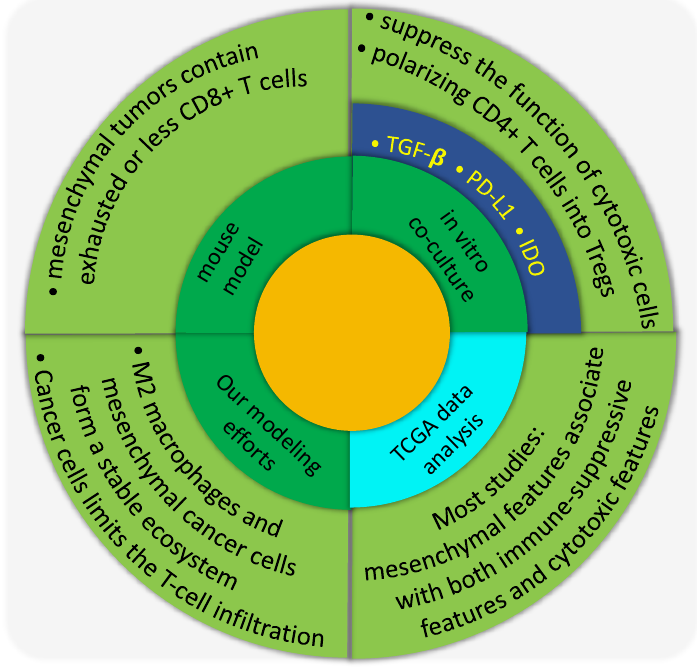
Figure 6. The relationship between EMT and immune response as shown by various approaches.